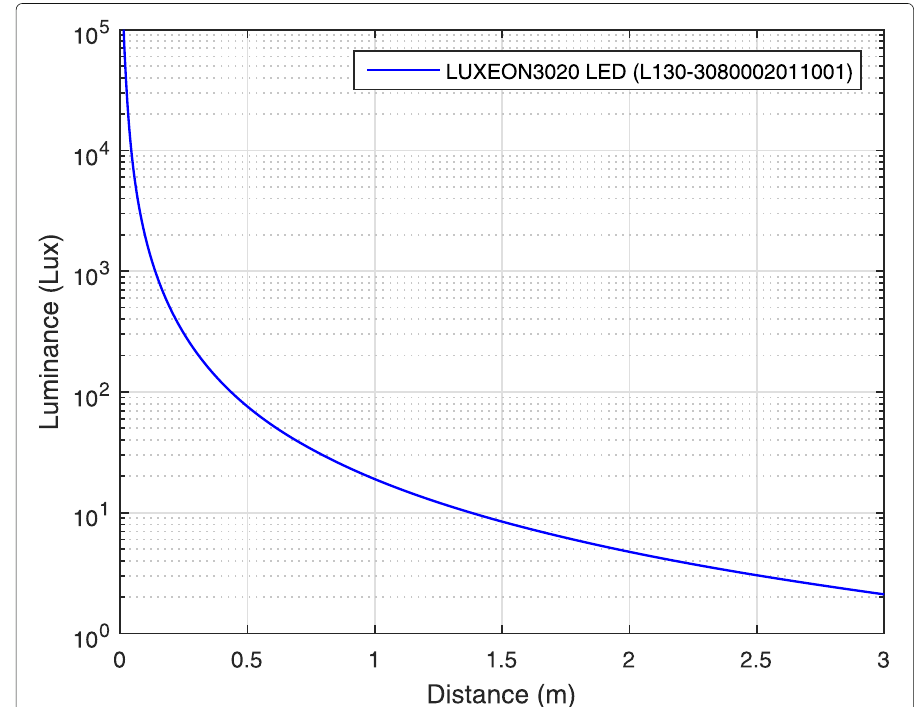
Fig. 1 Luminance from a single LED biased at 120 mA according to the distance with the illuminated